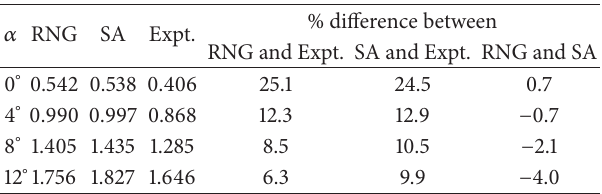
Table 1: Comparison of 𝐶 𝐿 predicted by 𝜅 - 𝜀 RNG and SA models at Re = 2.1 × 10 6 .